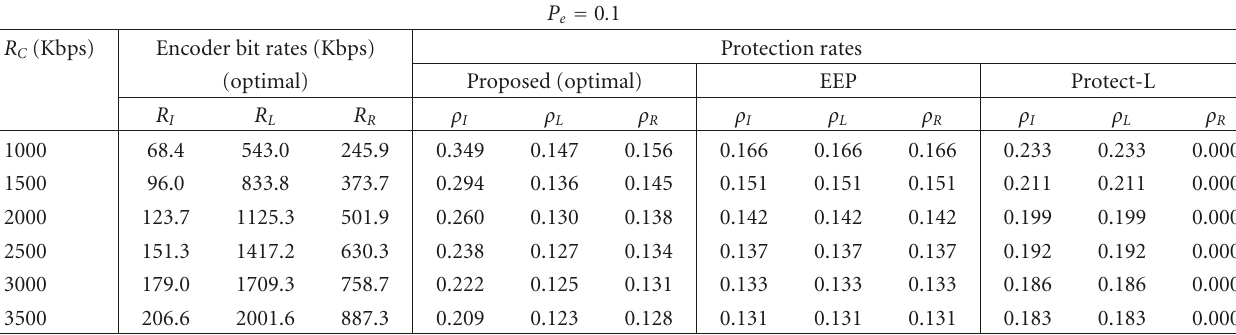
Table 4: Video encoder bit rates and Raptor encoder protection rates for “Soccer” video. P e = 0 .